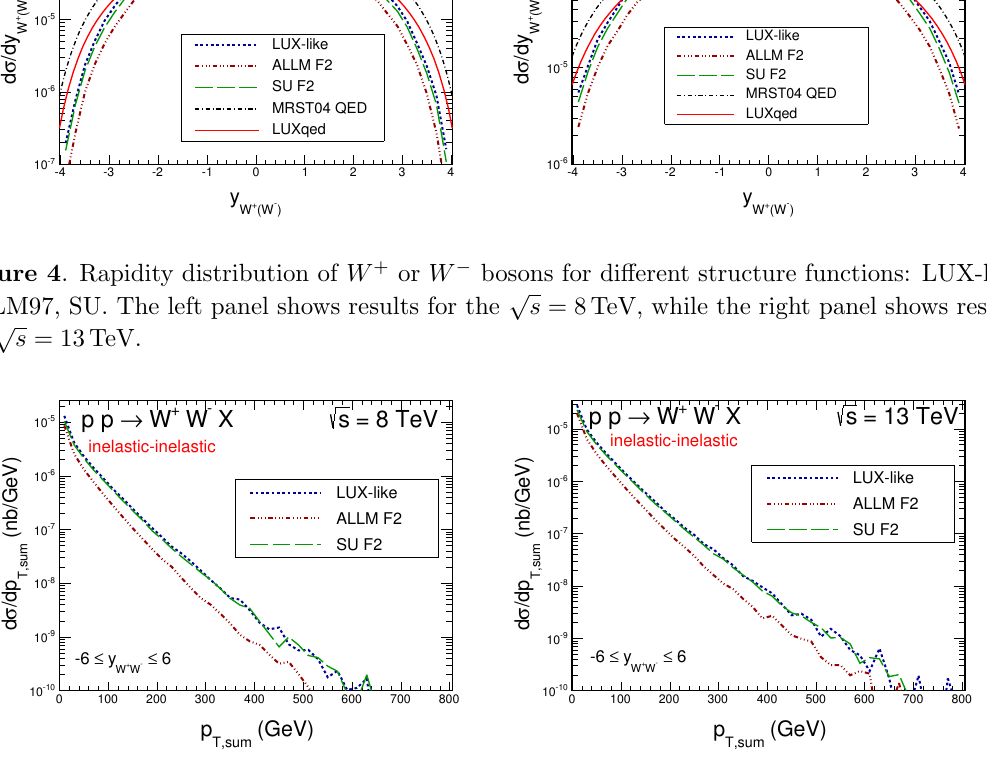
p s = 8 TeV, while the right panel shows